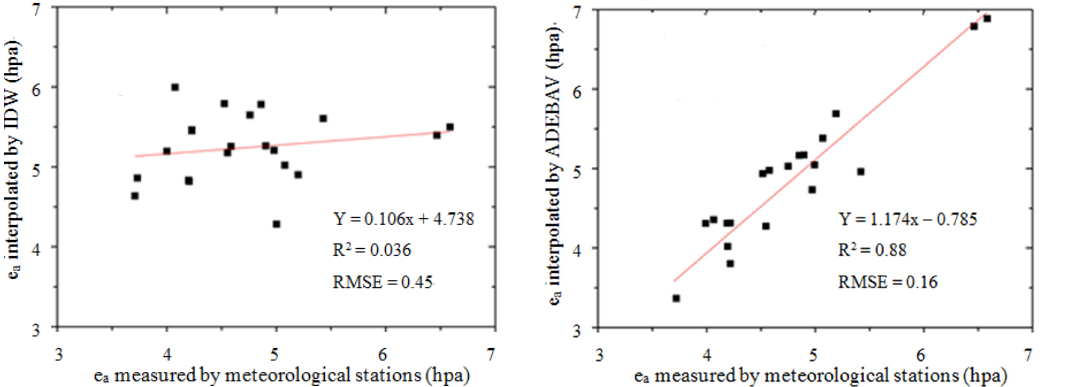
Figure 3. Comparisons between e a measurements and e a estimates from the IDW method ( left ) and the ADEBAT method ( right ) on 8 April, 30 August and 17 October in 2009